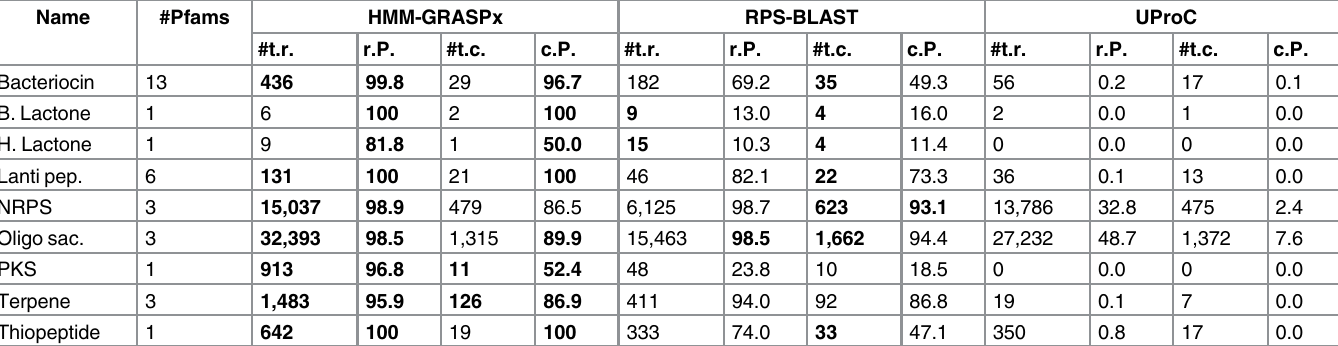
[39,40]. Knowledge of the resistome profile in an individual has potential applications for clini- cal treatment of bacterial infections. The AMR protein families registered in RESFAM [41] were selected as queries to profile the resistome (S9 Table). Twelve MG data representing six individuals, where each individual con- tributed to both a supragingival and a stool data set, were selected for this experiment (S10 Table). HMM-GRASPx and HMMER3 were individually applied to search the AMR profiles against these data sets (see Methods). Presented AMR protein families were selected (S9 Table) and their raw counts were further normalized into Reads Per Kilobase per Million (RPKM) to represent their abundance profile of the given MG data set (see Methods). The predicted AMR abundance profiles were further clustered using hierarchical clustering algorithm to show body site-specific resistome (see Methods). The clustering results of HMM-GRASPx- and HMMER3-predicted profiles are shown in Fig 2A and 2B, respectively. Table 2. Performances of the programs for searching biosynthetic protein family profiles against the human saliva data set SRS013942. Name